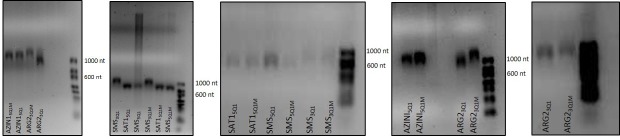
PAGE migration of long-looped G2-PQS’s in PSP UTRs upon in vitro transcription.The effect of PQS destabilizing mutations (M) in AZIN15Q1, ARG23Q1, SMS3Q1, SAT15Q1 and SMS5Q1 on in vitro transcription of Renilla luciferase mRNA on replicate gels. Smeared RNA can be observed for SMS5Q1, possibly due to RNA aggregation ( left gel).